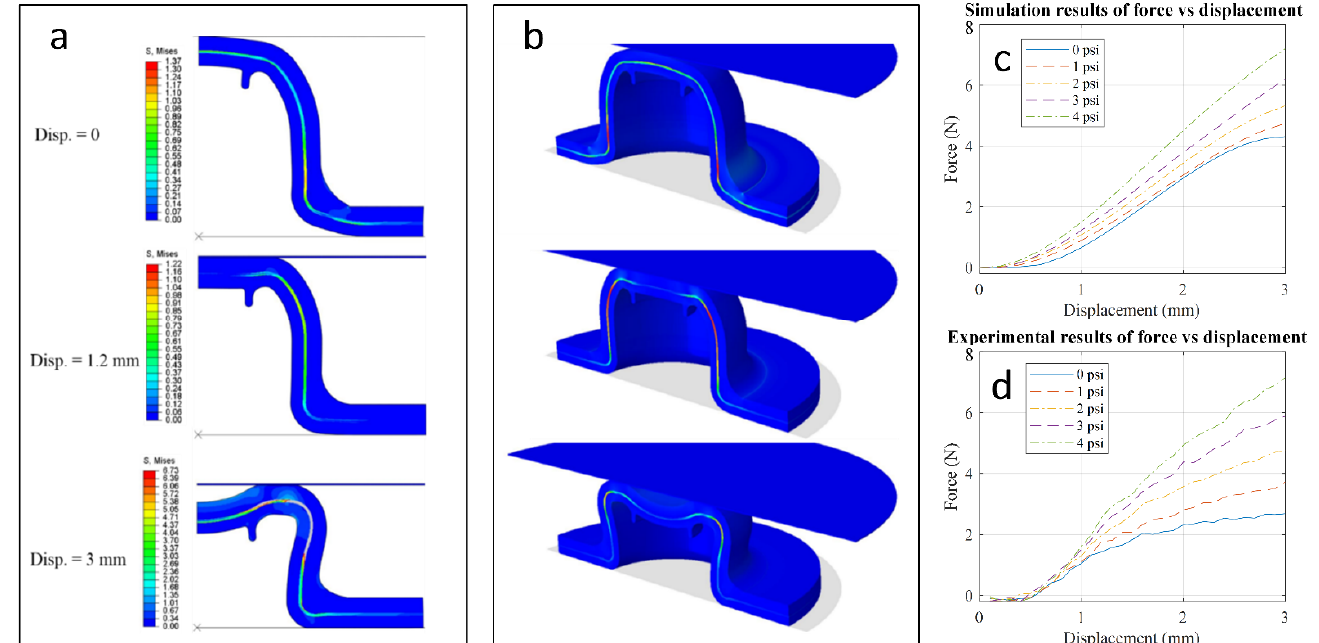
Figure 5. Deformation visualization of the fluidic dome with the Ecoflex 0050 soft layer pressurized at 3 psi and then indented up to 3 mm displacement using the 22 mm indenter: ( a ) two-dimensional (2D) view (legend shows the von Mises stress) and ( b ) 3D half model view. ( c , d ) show simulation and experimental force vs. displacement results for the fluidic dome with Ecoflex 0050 soft layer, respectively.